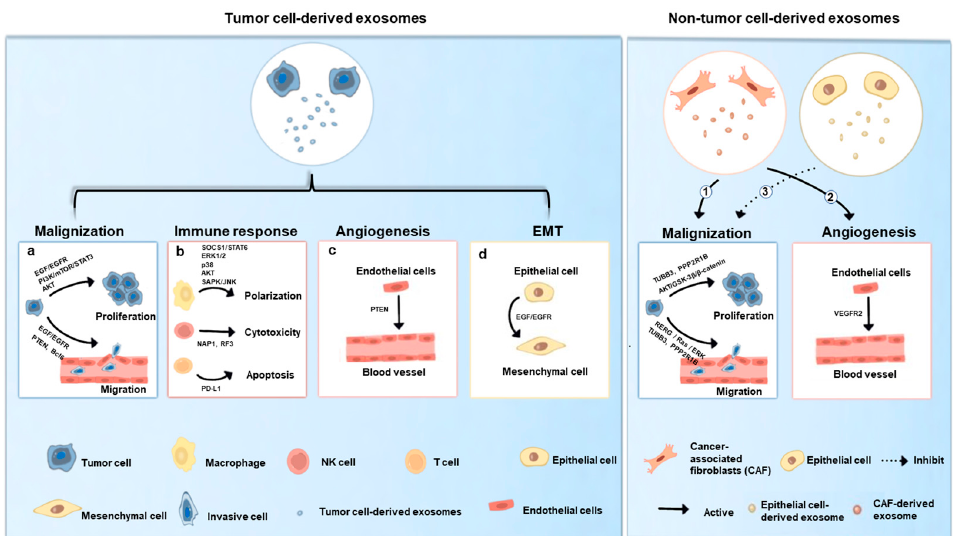
Figure 2. Exosomes in the development of OSCC. Tumor cell-derived exosomes (TEXs) support tumor development through promoting malignization of tumor cells ( a ), inhibiting antitumor immune responses ( b ), promoting angiogenesis ( c ) and promoting Epithelial-to-mesenchymal transition (EMT) ( d ). Cancer-associated fibroblasts (CAF)-derived exosomes contribute to tumor growth by promoting malignization of tumor cells ( 1 ) and angiogenesis ( 2 ). Epithelial cell-derived exosomes impair tumor growth through inhibiting malignization of tumor cells ( 3 ).